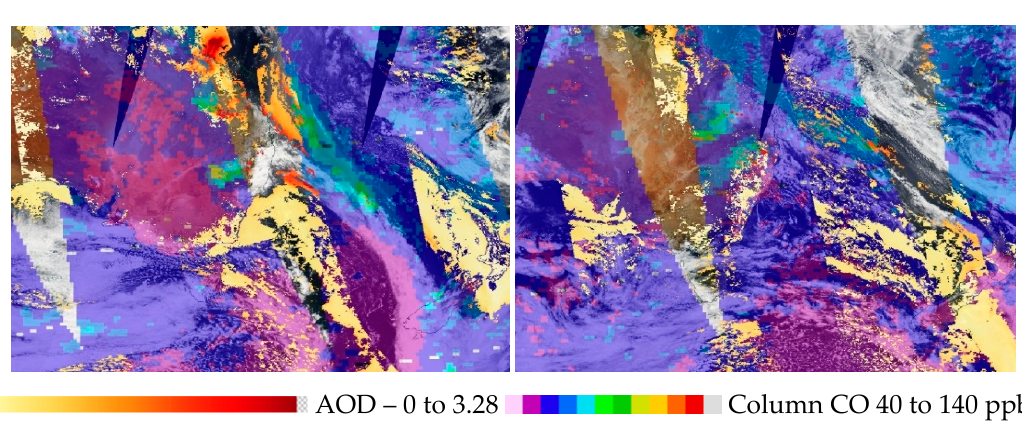
Figure 14. ( a ) NOAA HYSPLIT model matrix forward trajectory analysis from dust source areas in Central Australia with particle release times on 11 February 2019 4:00 UTC (left) and 12:00 UTC (right). ( b ) Same as ( a ), but using ArcGIS to display selected trajectories.